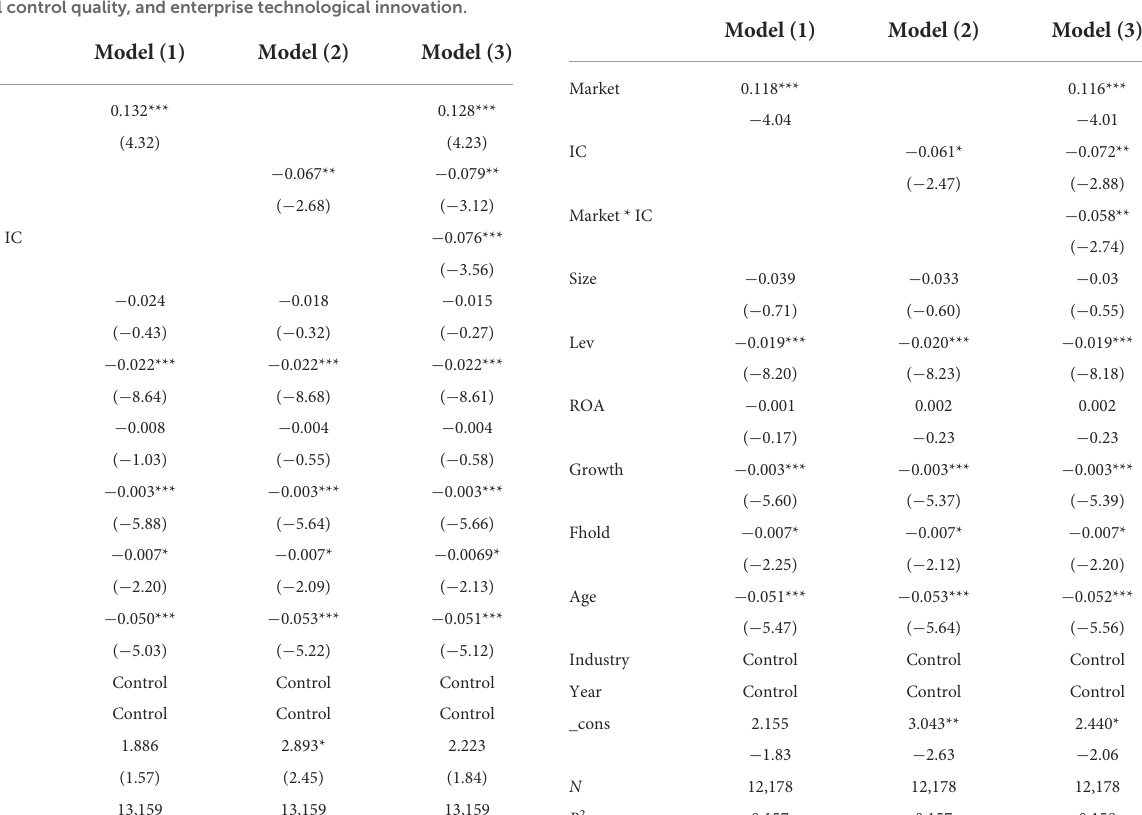
TABLE 5 Regression results of samples from high-tech